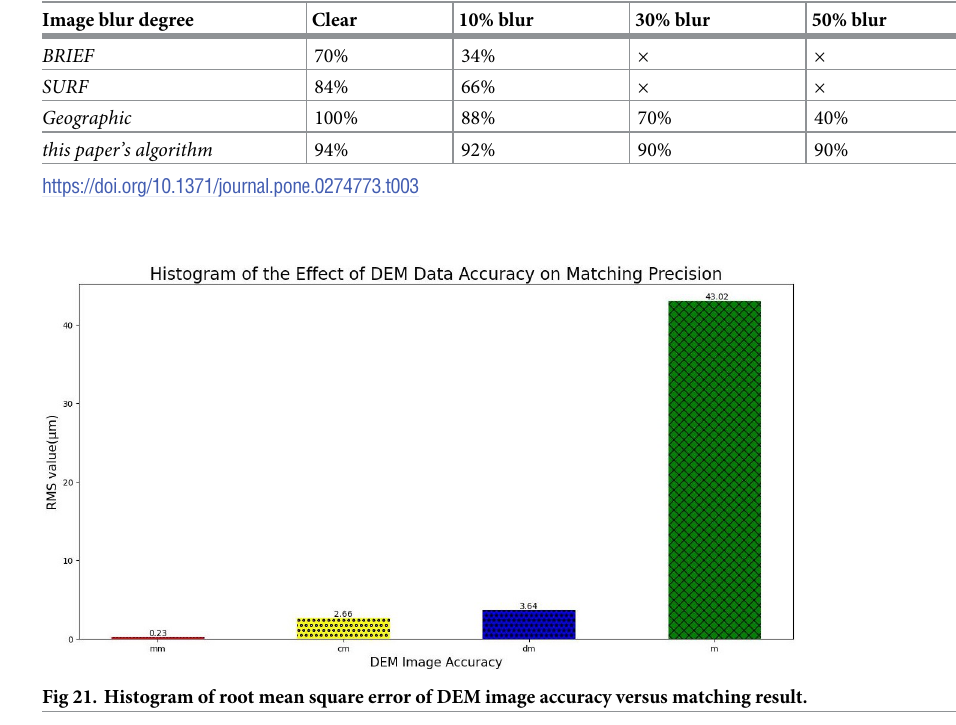
Table 3. Matching precision of each feature matching algorithm in different image sharpness.